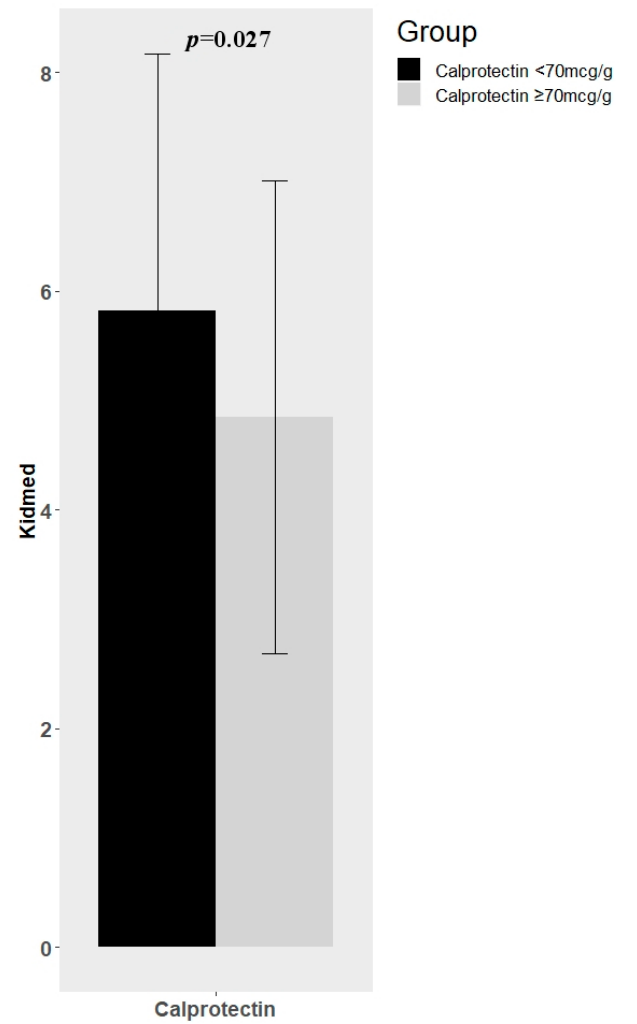
Figure 2. Difference in Mediterranean Diet Quality Index (KIDMED) mean between IBD Figure 2. Di ff erence in Mediterranean Diet Quality Index (KIDMED) mean between IBD (Inflammatory (Inflammatory Bowel Disease) children with normal levels (<70 mcg/g) and high levels (>70 mcg/g) Bowel Disease) children with normal levels ( < 70 mcg / g) and high levels ( > 70 mcg / g) of fecal of fecal calprotectin.